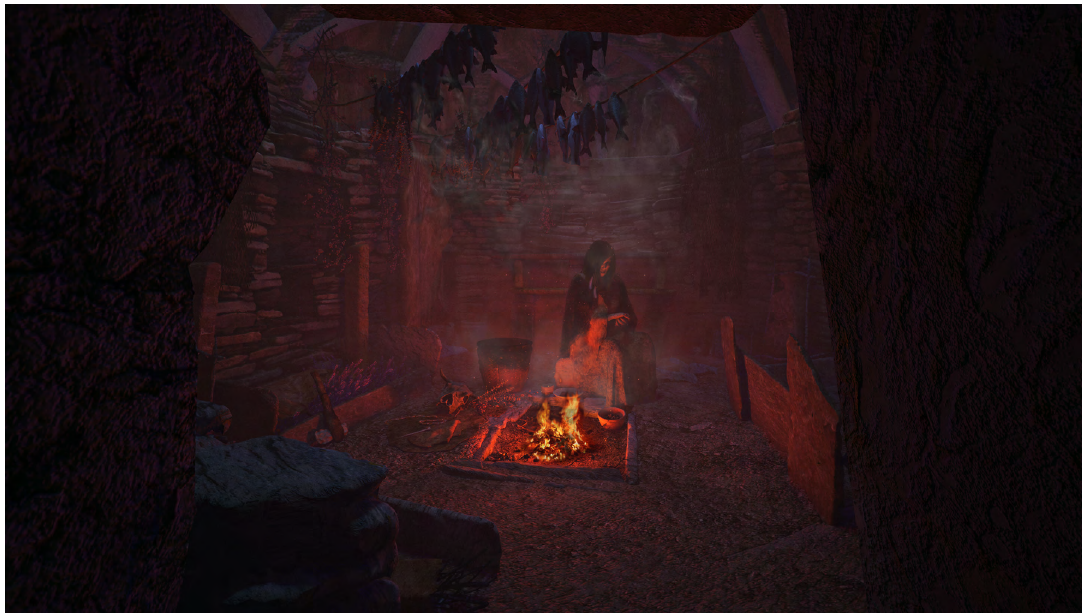
Figure 2: A still of the reconstructed interior of House 7 at Skara Brae from the Digital Dwelling film (see https://vimeo.com/